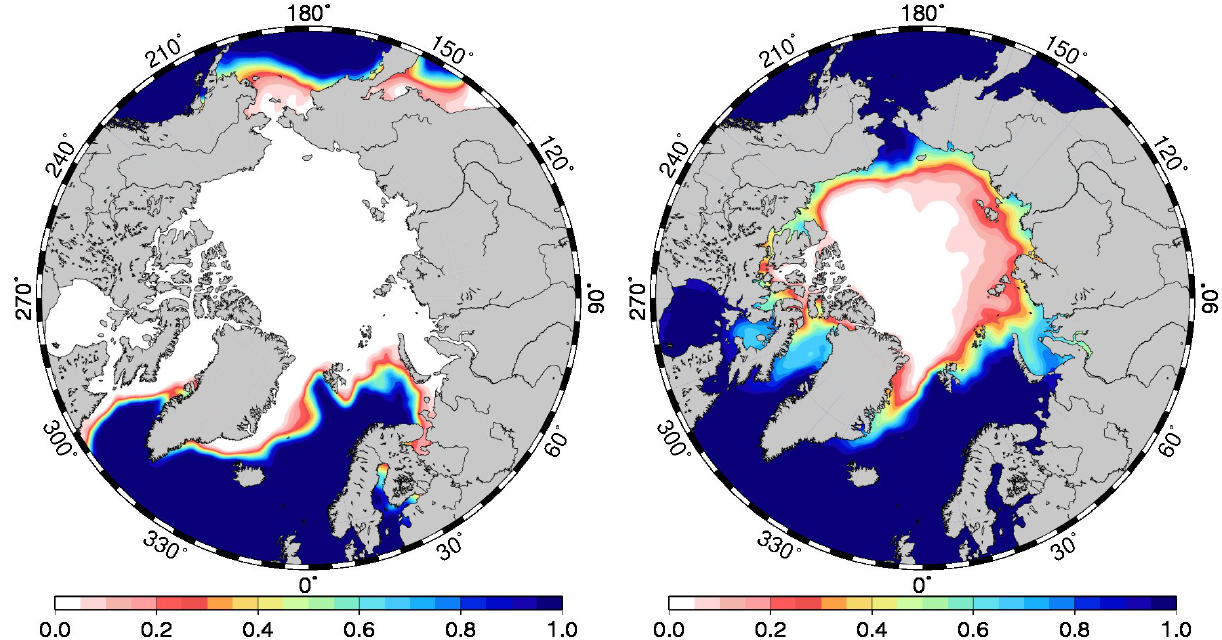
Fig. 11. Probability that the ocean is free of ice [ p(f = 0 ) ], as computed from the non-stochastic ensemble for 15 March (left panel) and 11 September (right